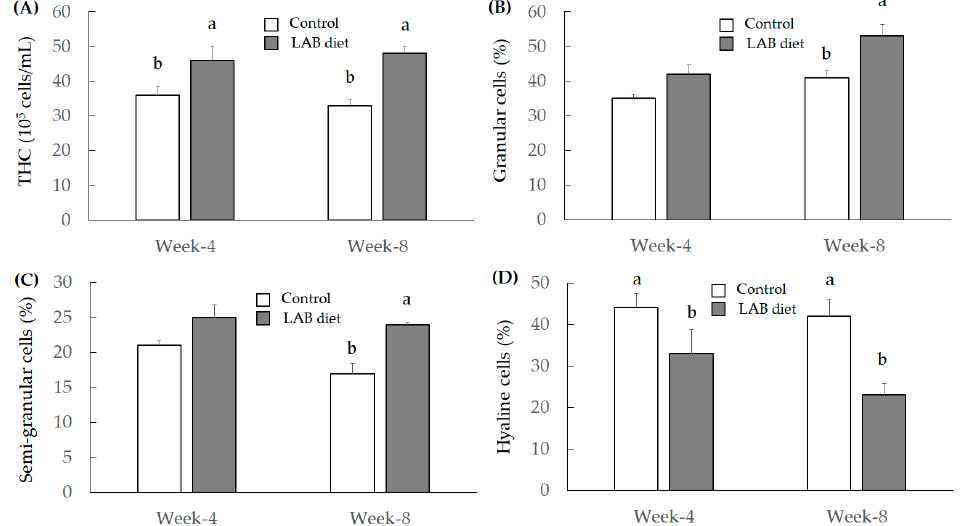
Figure 1. The variations of THC ( A ), granular cells ( B ), semi-granular cells ( C ), and hyaline cells ( D ) in shrimp feed with control or LAB feed. Significant difference is shown by different letters (a, b) ( p < 0.05) between control and LAB feed groups.